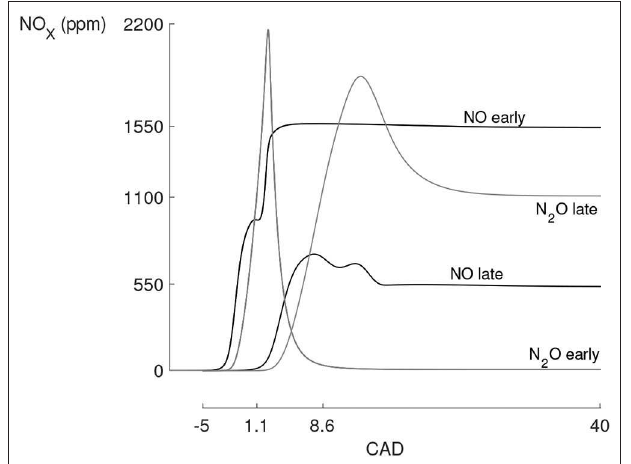
FIGURE 20 | NO and N 2 O production-consumption curves for an early and a late combustion. The late combustion happens below 1,400 K which is insufficient to reduce the pool of N 2 O. Simulation results obtained with the previously used single-zone model with the kinetic mechanism from Mathieu and Petersen (2015).